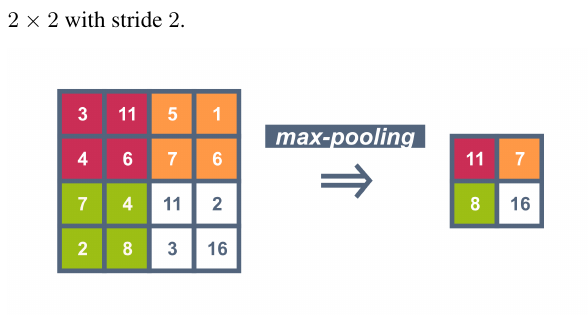
Figure 4. A Max-pooling